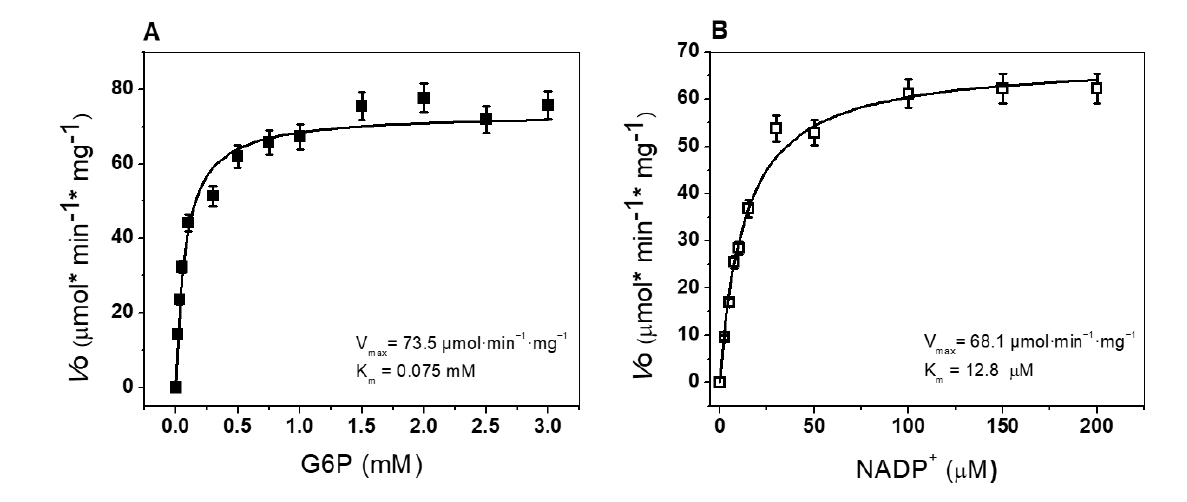
Figure 4. Saturation curves for the recombinant HpG6PD enzyme for the substrates ( A ) G6P and ( B ) NADP + . The initial velocity data for each point were obtained by varying the concentration of the substrates with a fixed and saturating concentration of NADP + or G6P, depending on the assay. These data were fitted to the Michaelis – Menten equation, using nonlinear regression calculations. Table 1. Previously steady-state kinetic parameters, as reported for G6PDs enzymes.